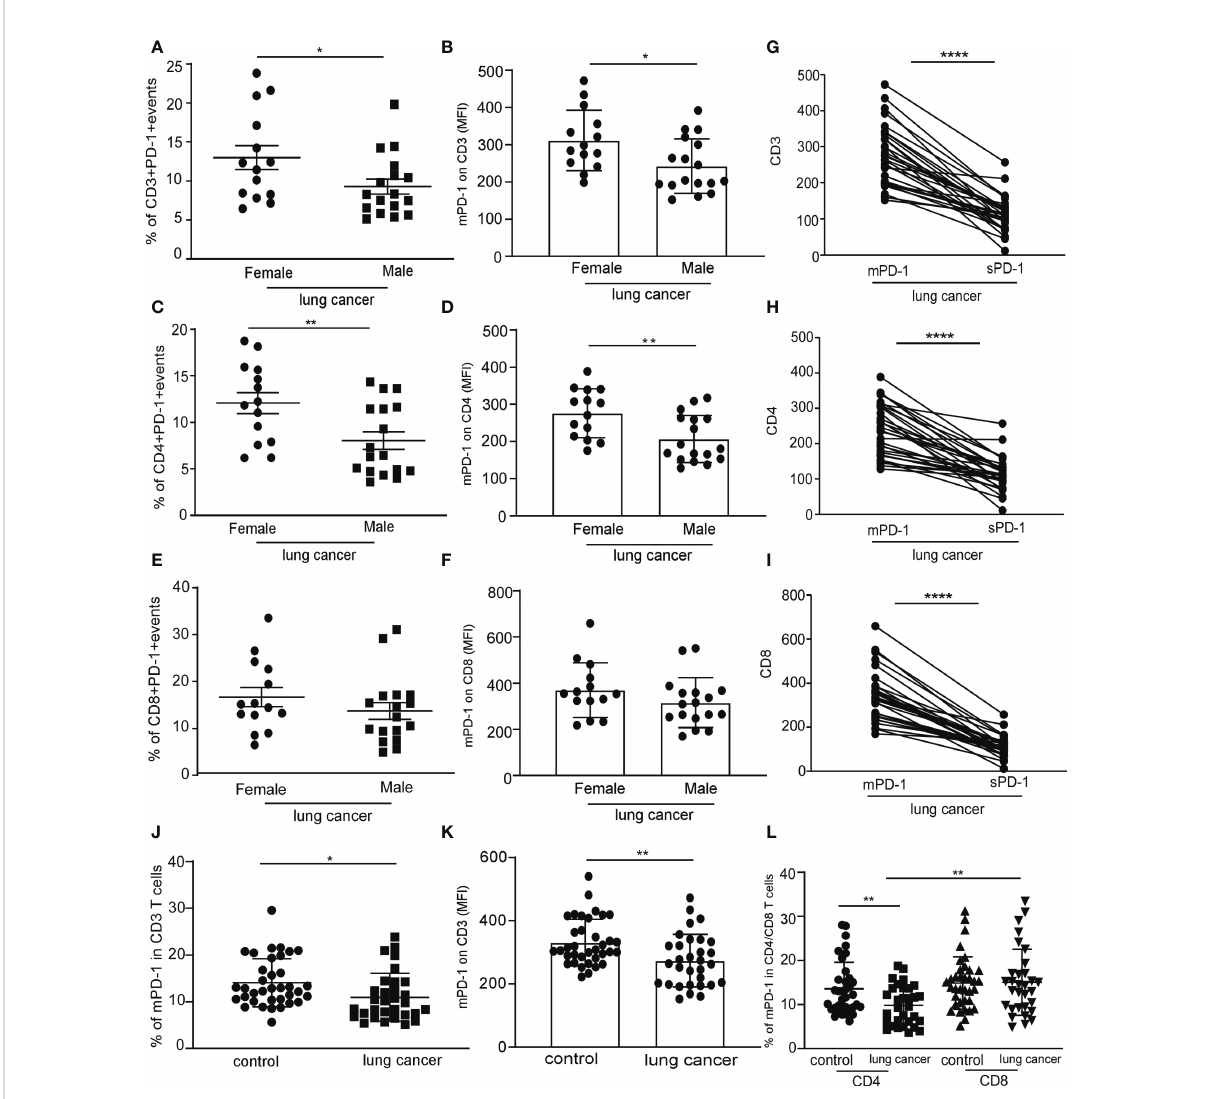
FIGURE 3 Higher expression of PD-1 on CD4+T cell in female lung cancer patients than that in male patients. Peripheral blood mononuclear cells (PBMCs) were separated from the blood of female and male lung cancer patients and were analyzed by fl ow cytometry; frequency of the CD3+PD-1+T cell (A) , CD4+PD-1+T cell (C) , and CD8+PD-1+T cell (E) in PBMCs from human lung cancer patients, expressed as mean ± SEM. * P < 0.05, ** P < 0.01; Mann – Whitney test (two-tailed) and nonpaired Student ’ s t -test. Mean fl uorescence intensity (MFI) of the CD3+PD-1+T cell (B) , CD4 +PD-1+T cell (D) , and CD8+PD-1+T cell (F) in PBMCs from human lung cancer patients, expressed as mean ± SEM. * P < 0.05, Mann – Whitney test (two-tailed) and nonpaired Student ’ s t -test; ligature between the expression of mPD-1 on CD3+T cell (G) , CD4+T cell (H) , CD8+T cell (I) , and serum sPD-1 on individual from lung cancer patients. (J) Percentage of CD3+PD-1+T cells in PBMCs from control and lung cancer patients. (K) MFI of CD3+PD-1+T cells in PBMCs from control and lung cancer patients. (L) Percentage of CD4+/CD8+PD-1+T cells in PBMCs from control and lung cancer patients, expressed as mean ± SEM. * P < 0.05, ** P < 0.01, **** P < 0.0001, Mann – Whitney test (two-tailed) and nonpaired Student ’ s t